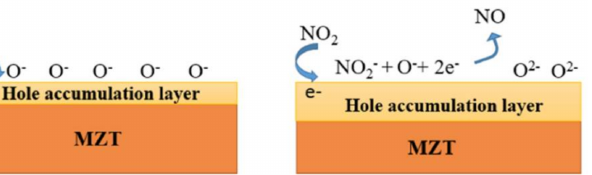
Figure 16. Schematic diagram of the sensing mechanism of the MZT thin film in an NO 2 atmosphere.